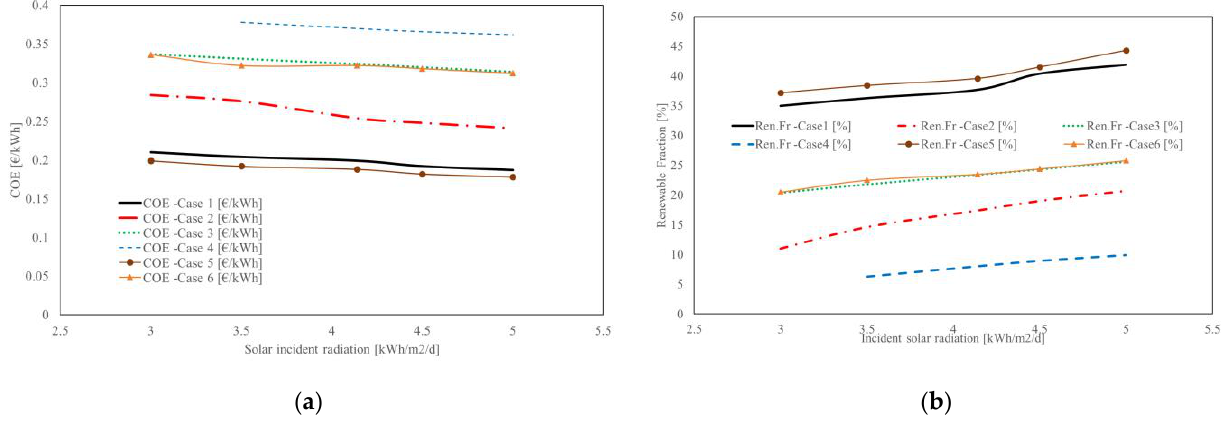
Figure 4. Solar potential parametric studies result. ( a ) COE vs solar potential; ( b ) Ren.Fr. vs. solar potential.